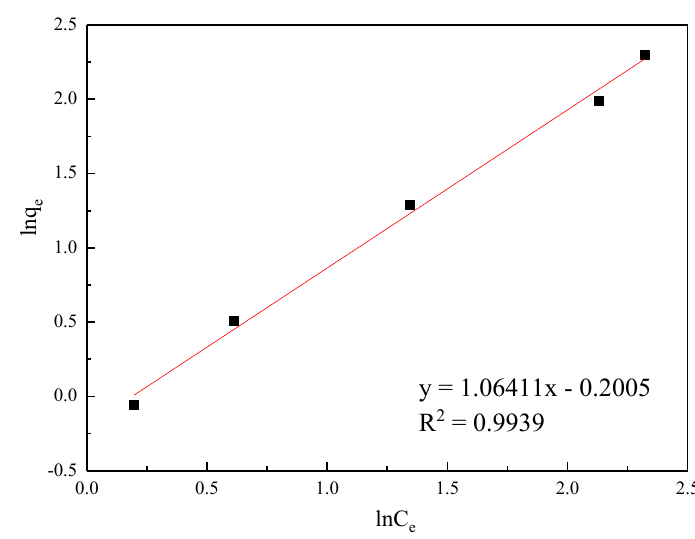
Figure 15. Linear regression of the Freundlich isotherm model (298 K).